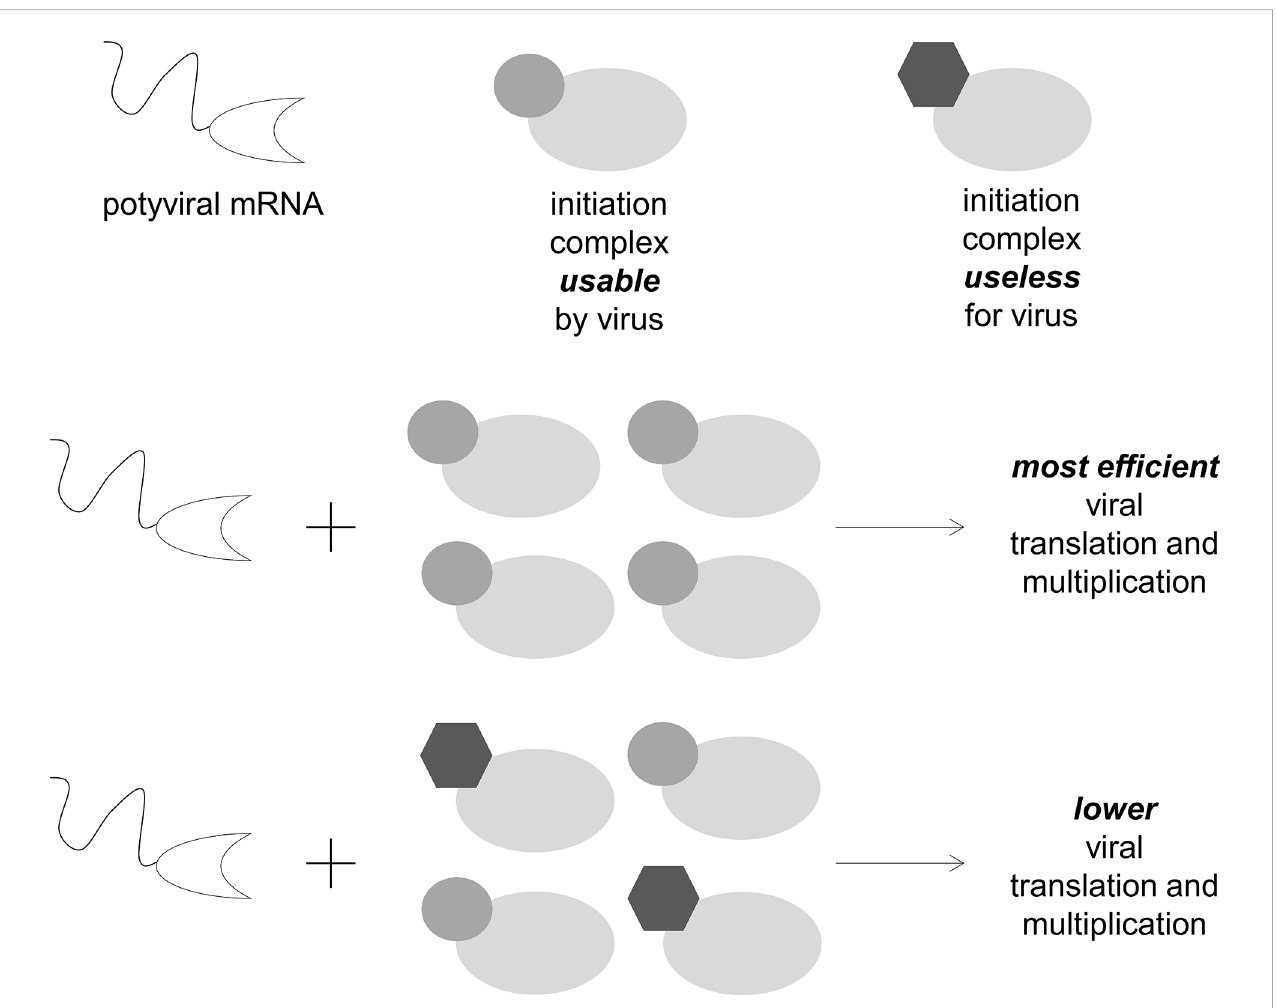
FIGURE 3 eIF4E isoforms that cannot be used by viruses can decrease their accumulation in plant cells by the mutual regulation of concentration and competition